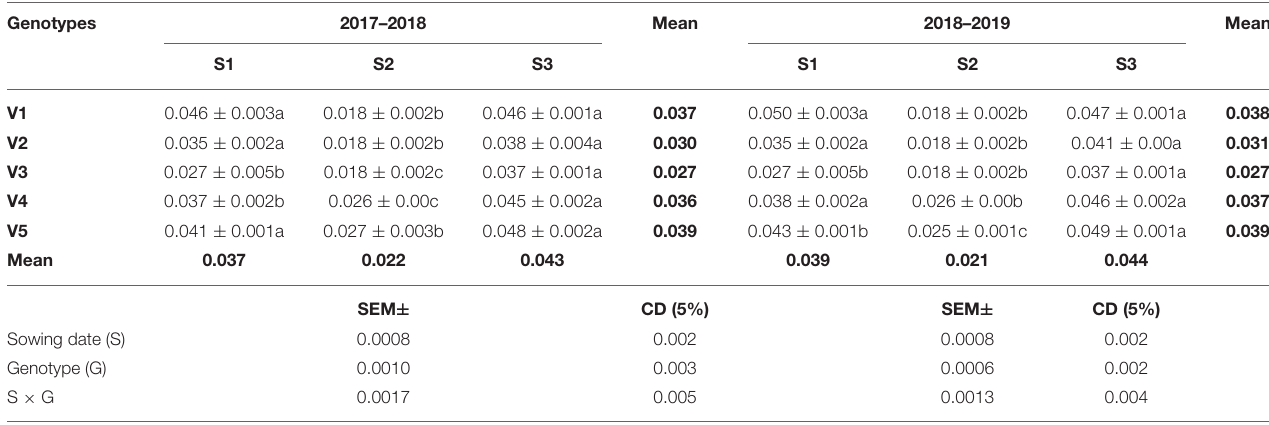
TABLE 3 | Polyphenol oxidase (PPO) activity (EU mg − 1 protein min − 1 ) at mid-flowering stage in top leaf of mustard varieties sown at three different dates during rabi 2017–2018 and 2018–2019. Genotypes